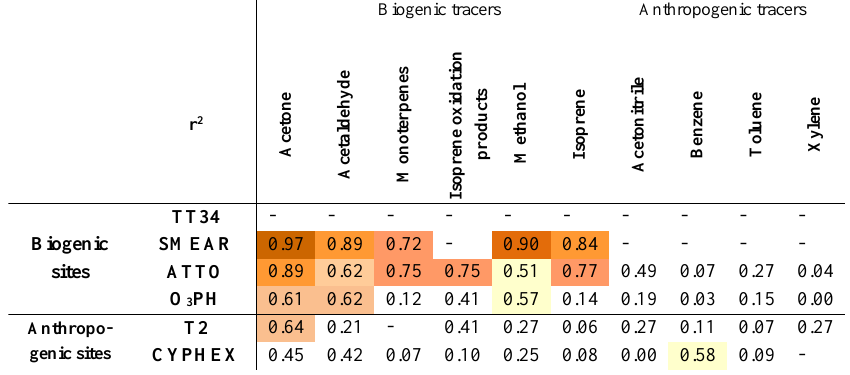
Table 3: Literature compilation of MEK mixing ratios measurements in different ecosystems around the